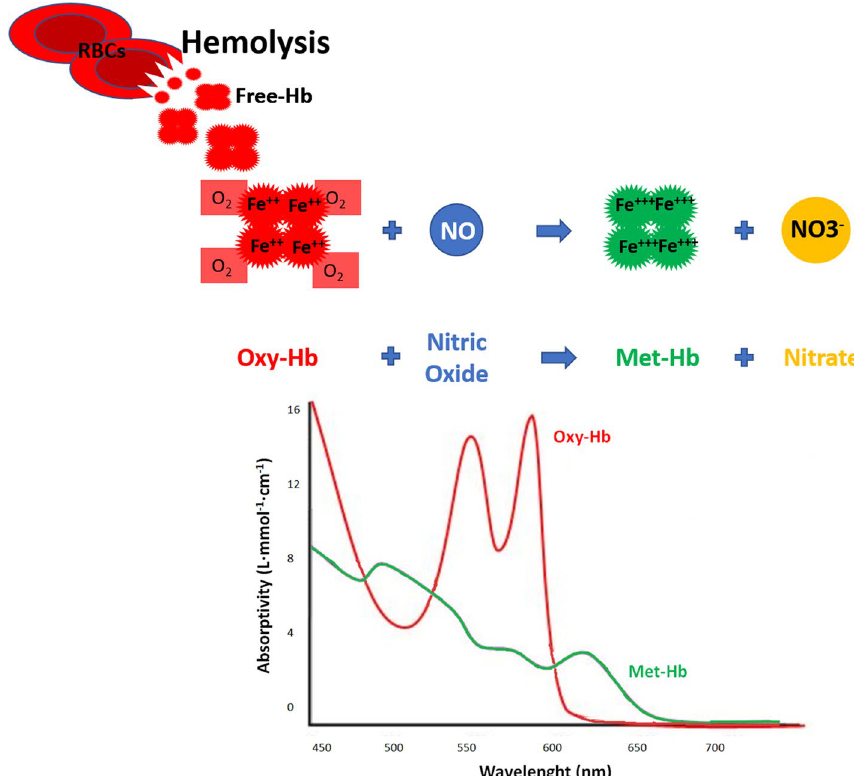
Fig. 2 NO scavenging in hemolysis. The di-oxygenation reaction: during intravascular hemolysis in human disease, oxy-Hb (Fe 2 + ) is able to rapidly bind NO, to form bio-inactive NO 3 − and met-Hb (Fe3 + ). The NO scavenging causes consequently vasoconstriction. Exogenous NO can prevent this phenomenon by minimizing the scavenging of endogenous NO. The graph represents the different light absorption wavelengths of oxy-Hb and met-Hb. NO: nitric oxide; Hb: hemoglobin; RBC: red blood cell; NO3 − :